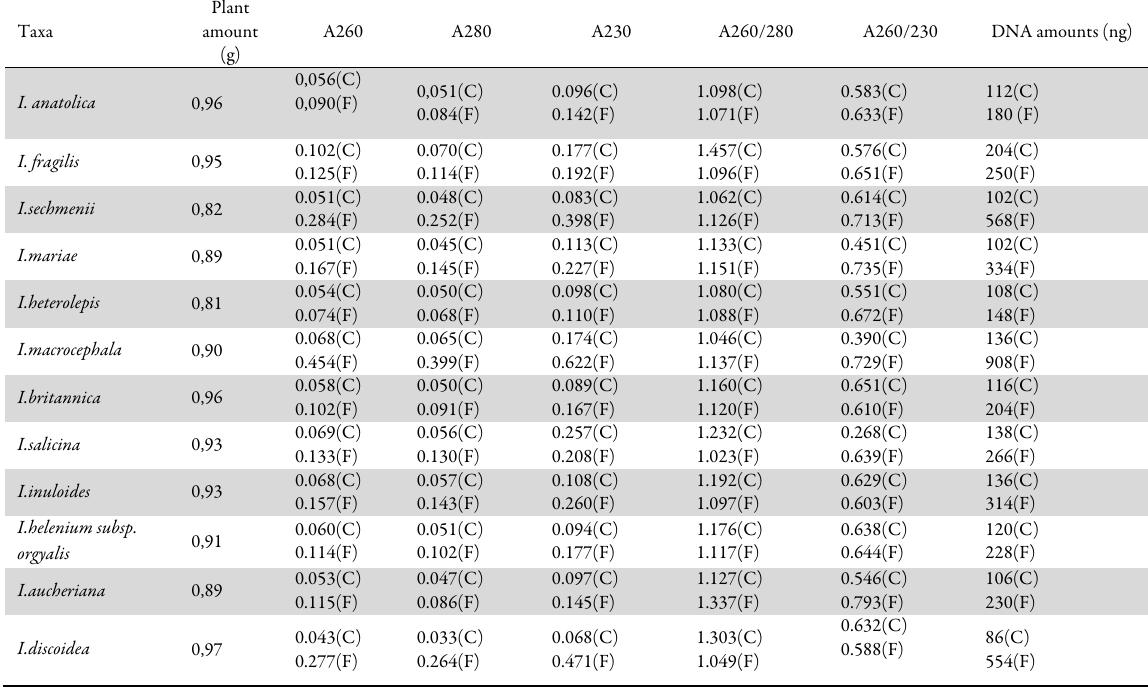
Table 2. Spectrophotometric measurements, purity amounts, and DNA amounts of the DNAs belonging to the Inula taxa collected (C: Commercial Ki t (Sigma), F: Phenol-cloroform isoamil)